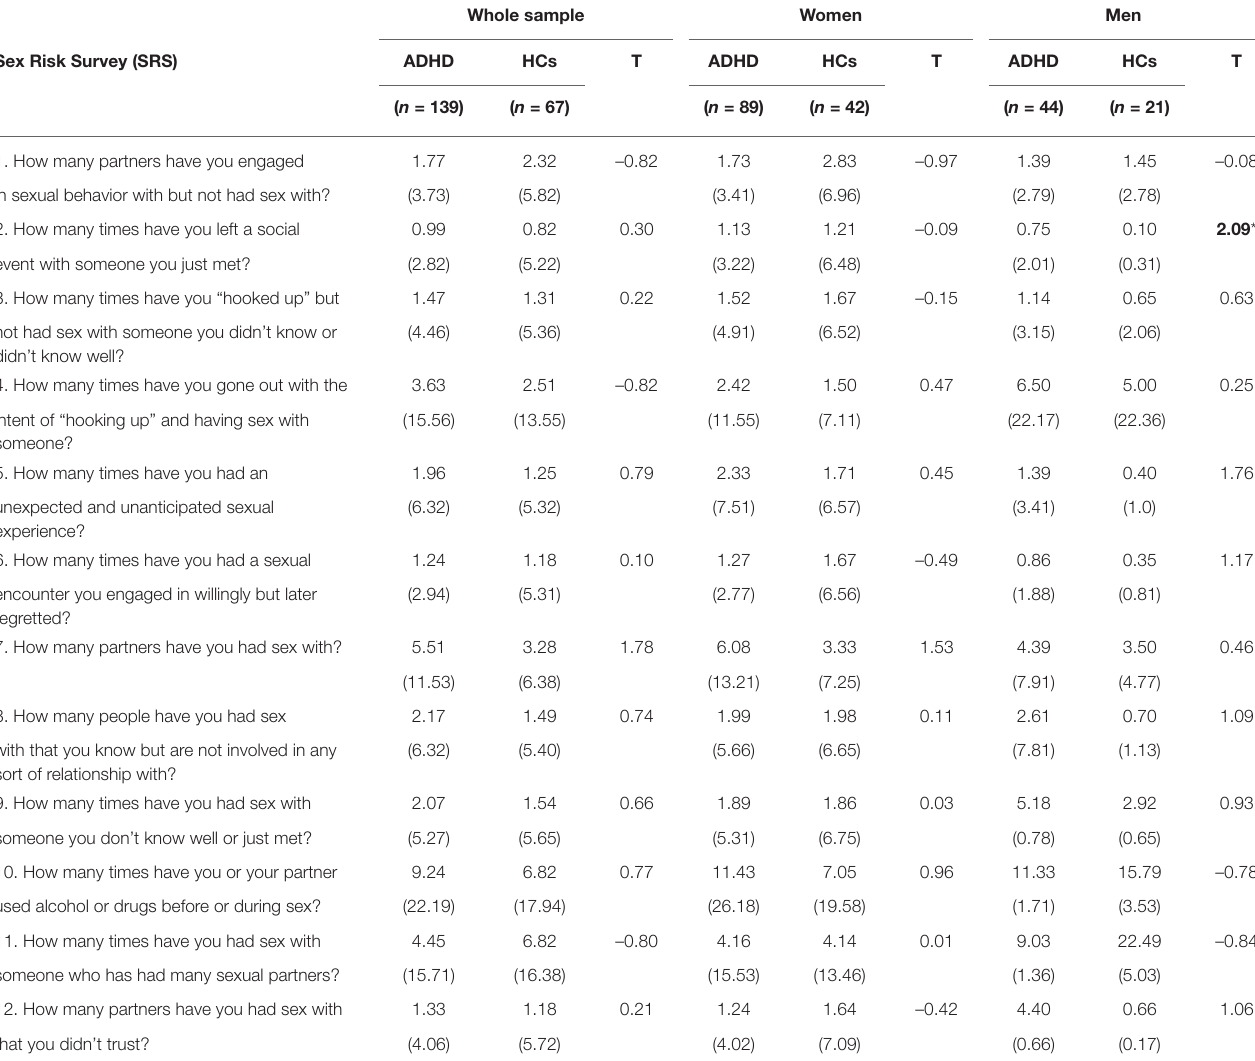
TABLE 5 | Comparisons of sexual risk behaviors between individuals with and without ADHD using the SRS. Whole sample Women